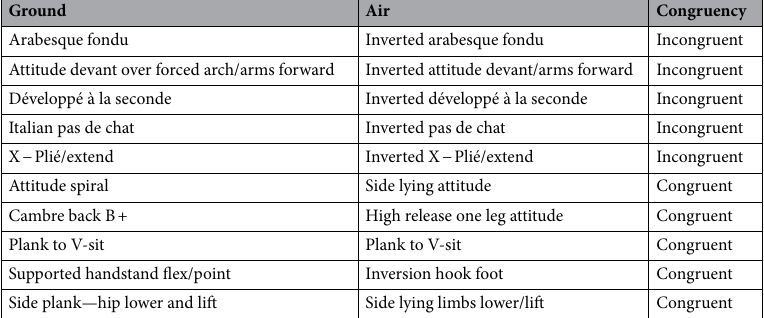
Table 1. List of dance movements. Error bars represent standard error of the